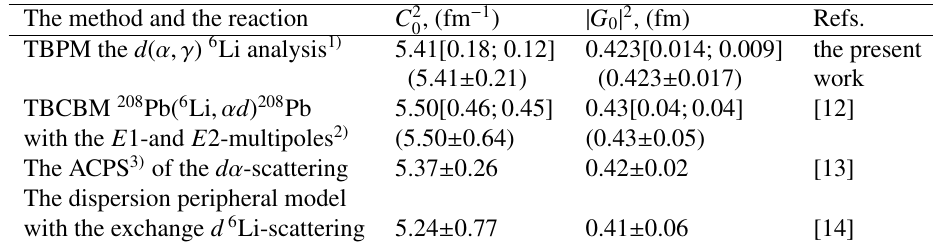
Table 1. The ANC square ( C 2 ) for α + d → 6 Li and the modulus square of the respective NVC for the 0 virtual decay ( | G 0 | 2 ). Figures in square bracket are experimental and theoretical uncertainty, respectively, whereas, those in bracket are the weighted means and their total